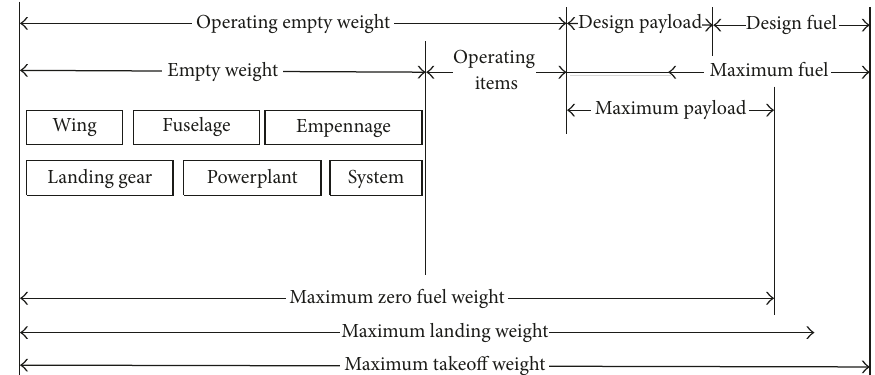
Figure 4: Aircraft weight breakdown and definition.